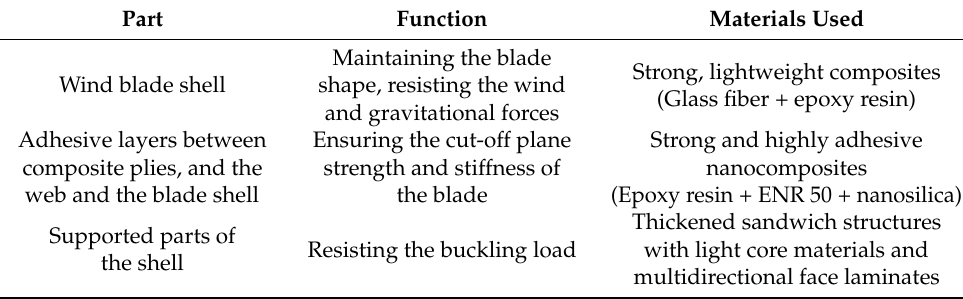
Table 3. Wind blade parts and their functions in maintaining the blade